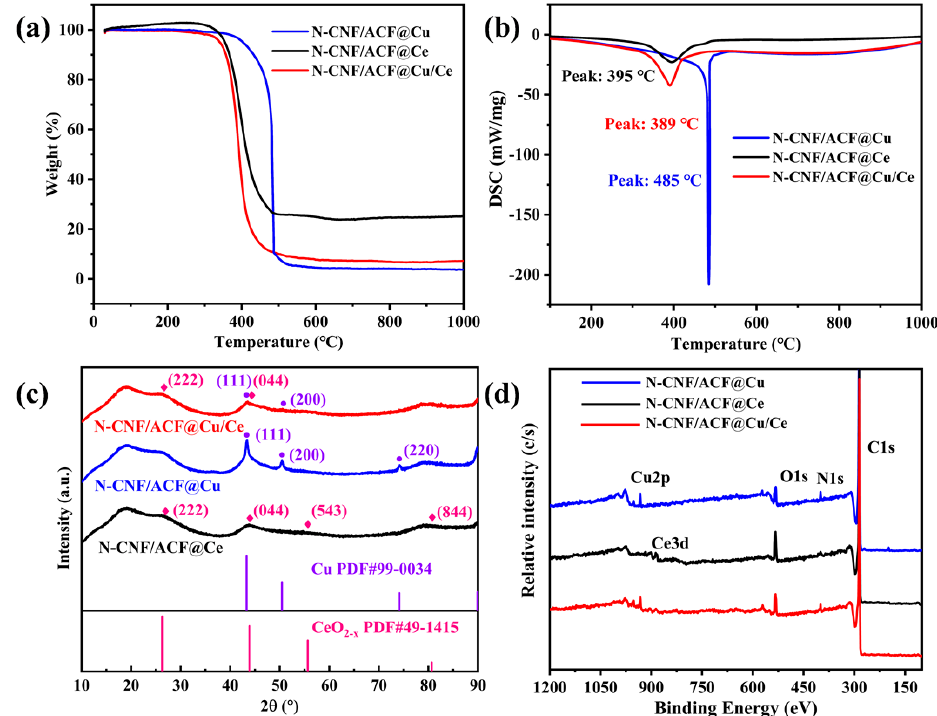
Figure 2. TG–DSC curves in air atmosphere ( a , b ), XRD patters ( c ) and XPS spectra ( d ) of N- CNF/ACF@Me.